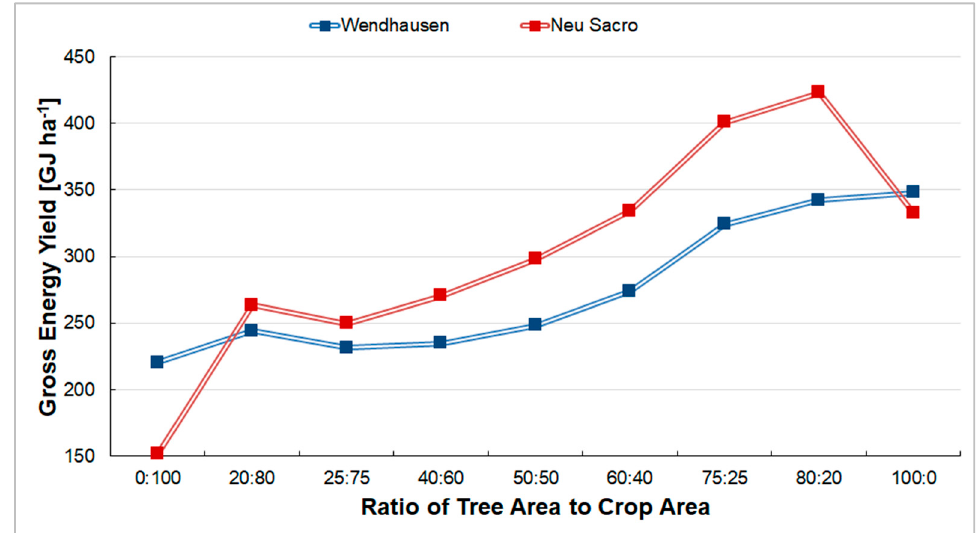
Figure 8. The effect of different ratios of tree area to crop area on the gross energy yield, calculated Figure 8. The e ff ect of di ff erent ratios of tree area to crop area on the gross energy yield, calculated with simulated yields for the ACSs at Wendhausen and Neu Sacro, in 2016 and 2017. with simulated yields for the ACSs at Wendhausen and Neu Sacro, in 2016 and